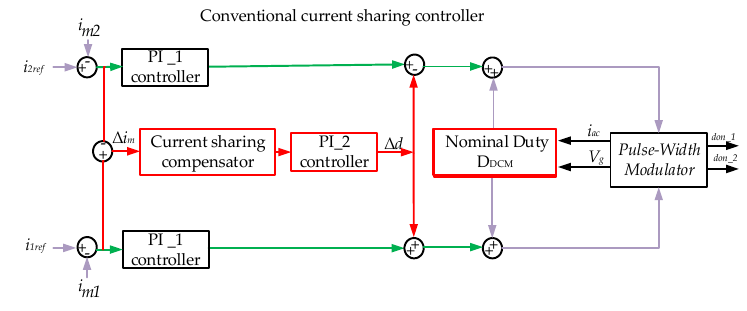
Figure 6. The PI control diagram of interleaved flyback micro-inverter in DCM.